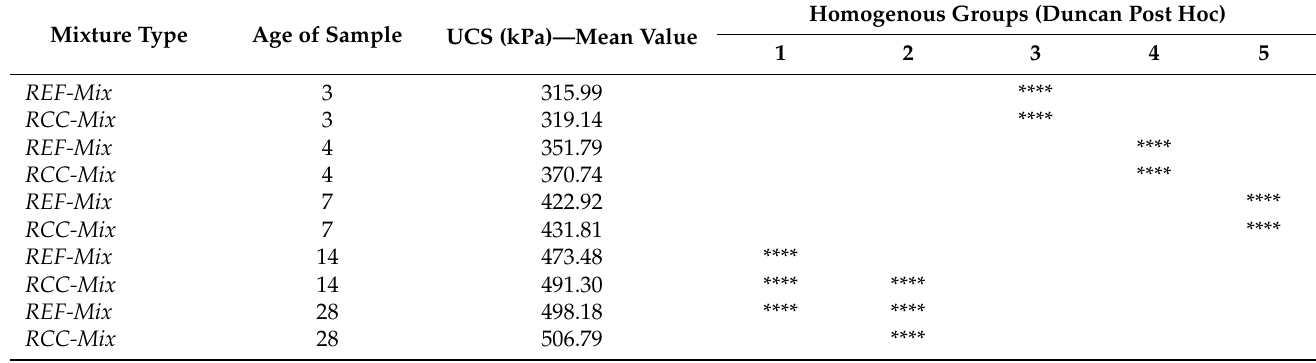
Table 15. Homogeneous groups isolated based on the results of the Duncan multiple comparison tests; criterion of no significant differences between the mean UCS values in the samples from the REF-Mix , RCC-Mix mixtures at significance level α = 0.05